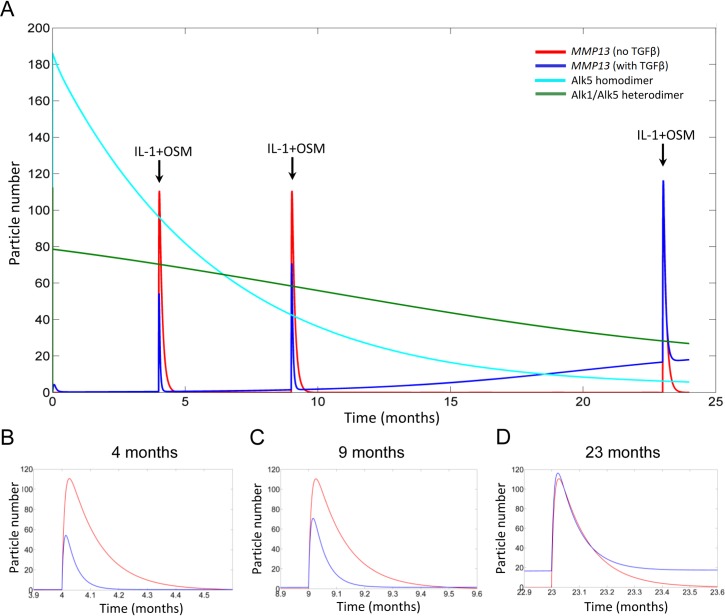
Modelling age-related changes of TGFβ responses to a pro-inflammatory stimulus.Deterministic simulation results for the model presented in Fig 2 run over a 24 month simulation time, using COPASI. The simulation was run with the total pool of TGFβ initially being in an inactive form to allow for the activation and deactivation of the growth factor throughout the simulation. IL-1+OSM were triggered using events at three time points at which the Alk1/Alk5 heterodimer:Alk5 homodimer ratio had changed. (A) Simulation output over 24 month period. Enlarged views of the change in MMP13 mRNA expression immediately before and after IL-1+OSM stimulation events at 4 months (B), 9 months (C) and 23 months (D) are shown. Changes in Alk5 homodimers (light blue line), Alk1/Alk5 heterodimers (green line), MMP13 mRNA expression in the absence of TGFβ (red line) or MMP13 mRNA expression in the presence of TGFβ (dark blue line) over 24 months are presented. Model parameters are given in S1 and S2 Files.